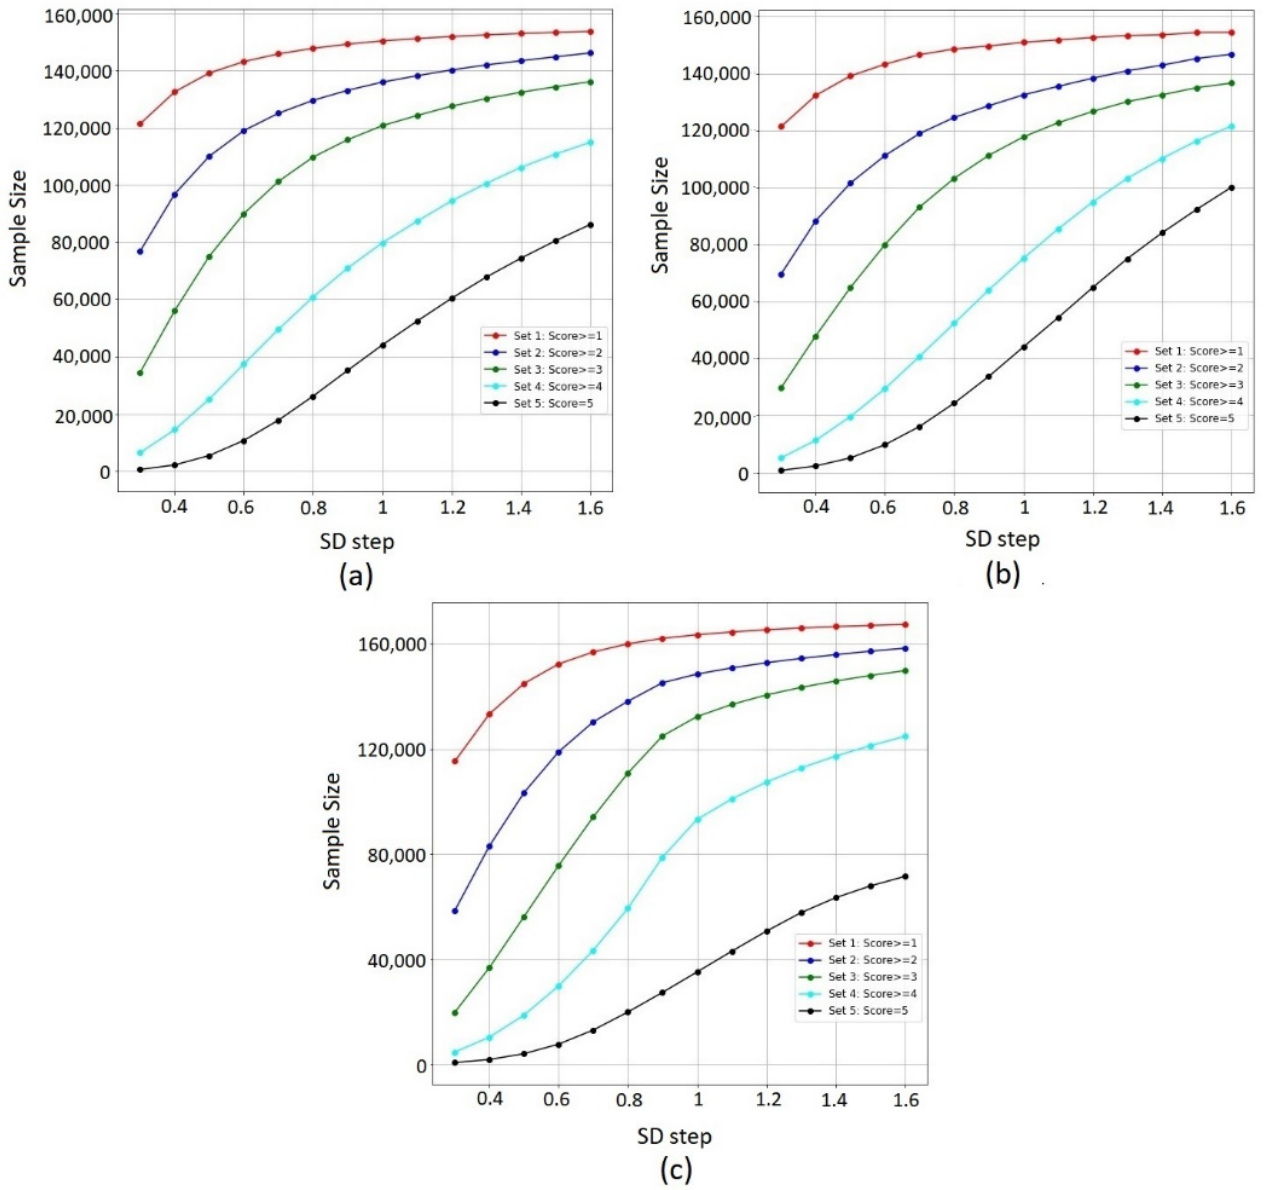
Figure 8. The growth rate of the sample size for each set in the target years: ( a ) 2021, ( b ) 2019, and ( c ) 2018.